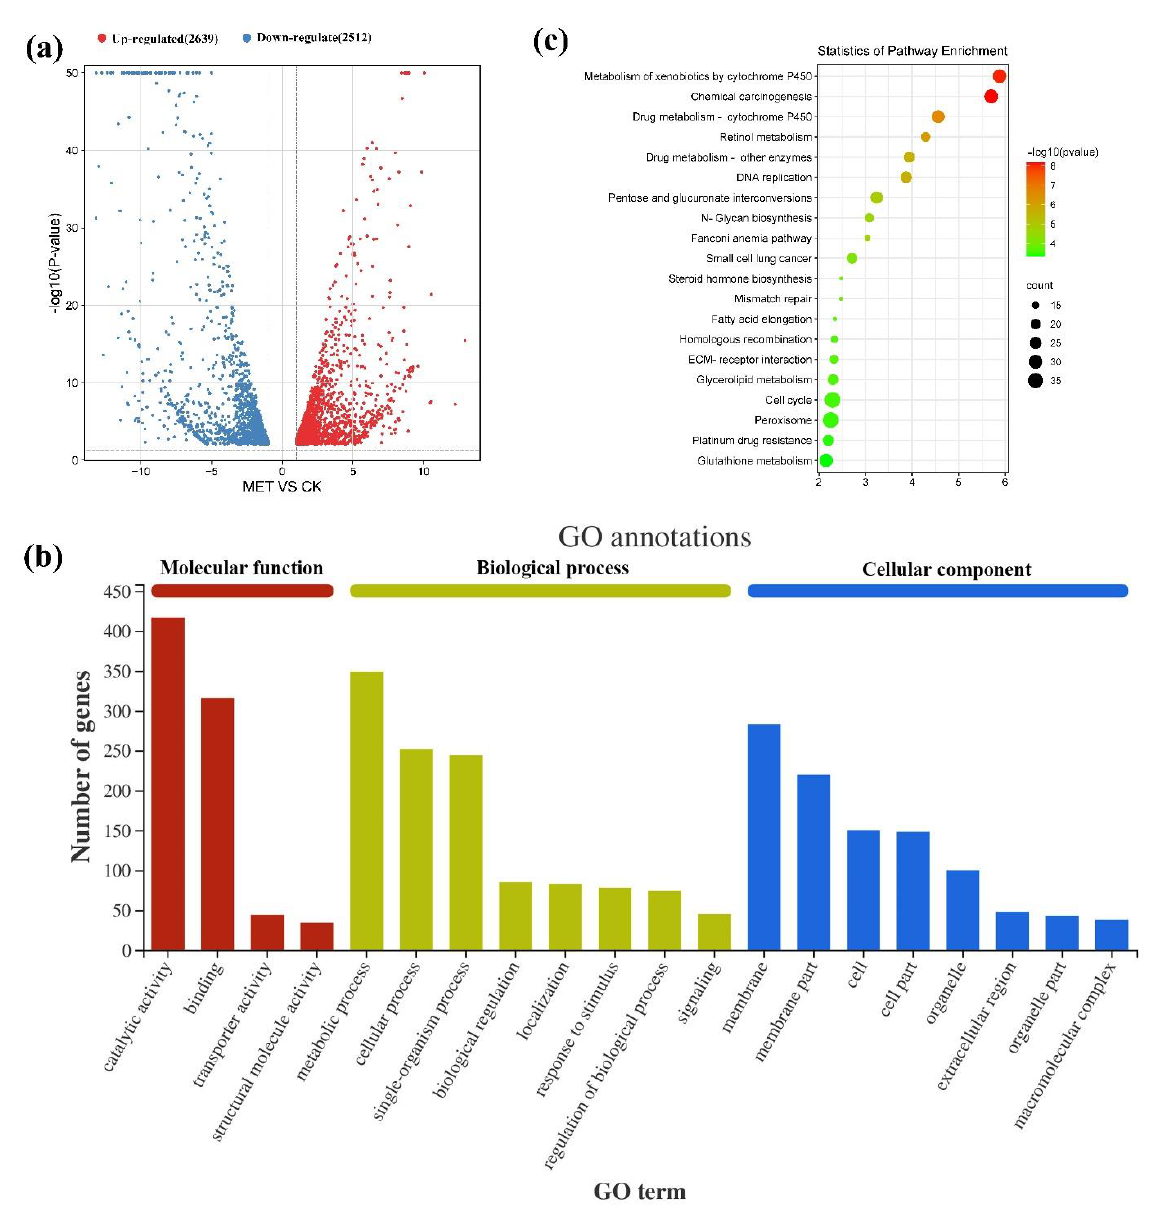
Figure 2. Function annotation and enrichment of DEGs. ( a ) Volcano plot of differentially expressed genes of S. exigua fed with MET (red spots represent significantly up-regulated genes; green spots represent significantly down-regulated genes). ( b ) GO function annotation analysis of S. exigua fed with MET (metabolic process under biological process had the primary number of UniGenes. The catalytic activity and binding under the molecular function were the most dominant. The membrane under the cellular component were the biggest group). ( c ) The most enriched KEGG pathways of S. exigua after exposure to a sublethal concentration of MET.